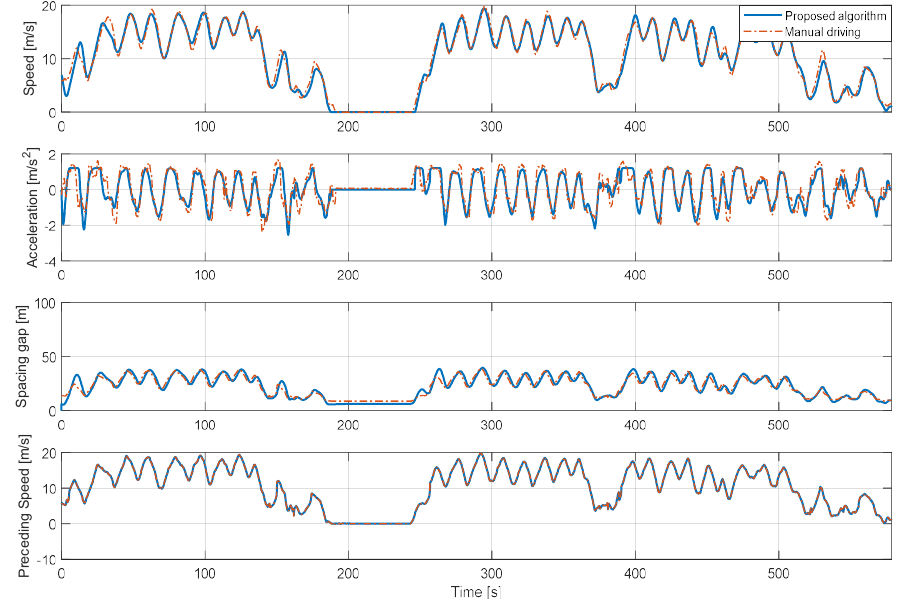
Figure 11. Driving simulation results of the proposed algorithm of 1st driver for the entire route.